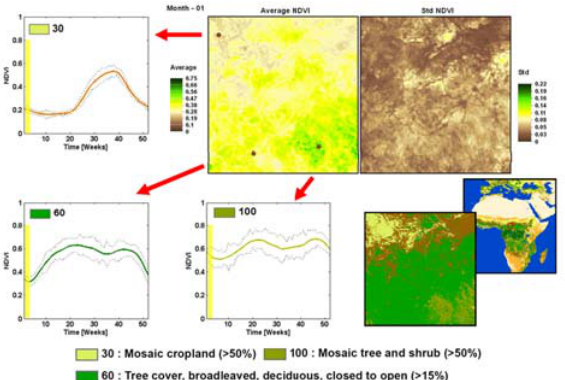
Figure 8. Detailed spatial example of NDVI climatological profiles - mean (plain line) and standard deviation (dotted line) - extracted in a region of Central